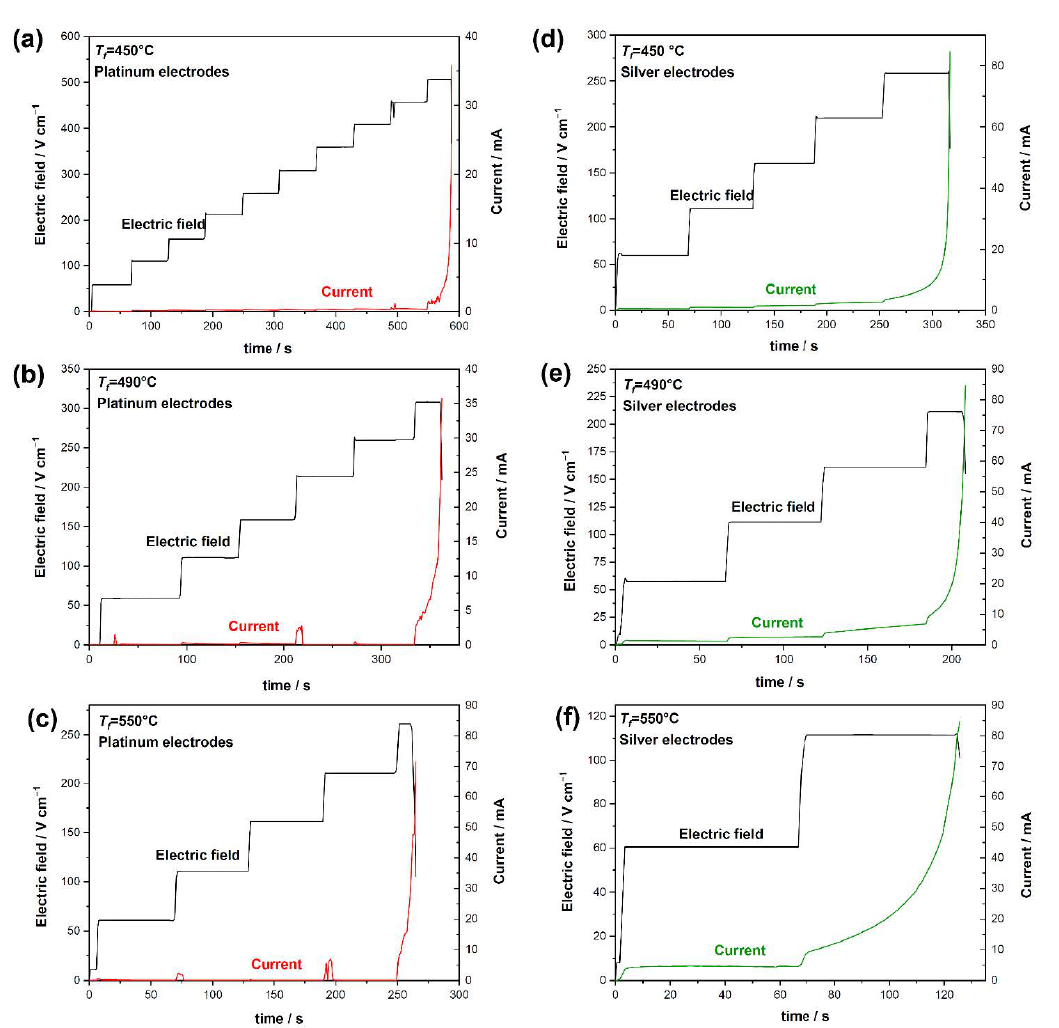
Figure 2. Electric field and current for the experiments carried out in the furnace using Pt configurations at ( a ) 450 ◦ C, ( b ) 490 ◦ C and ( c ) 550 ◦ C, and Ag configurations at ( d ) 450 ◦ C, ( e ) 490 ◦ C, and ( f ) 550 ◦ C.